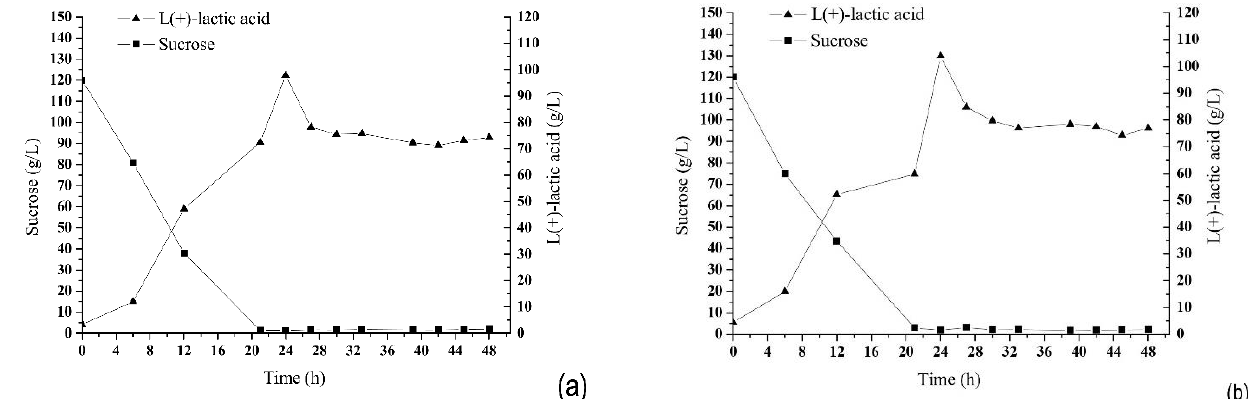
Figure 6. Kinetics of L(+)-lactic acid production, sucrose consumption and growth of microorganism L. casei Ke11 in 0.5-L batch reactor using CaCO 3 to control pH, ( a ) initial sucrose concentration of 120 g/L in absence of salts from MRS medium and ( b ) presence of salts from MRS medium.